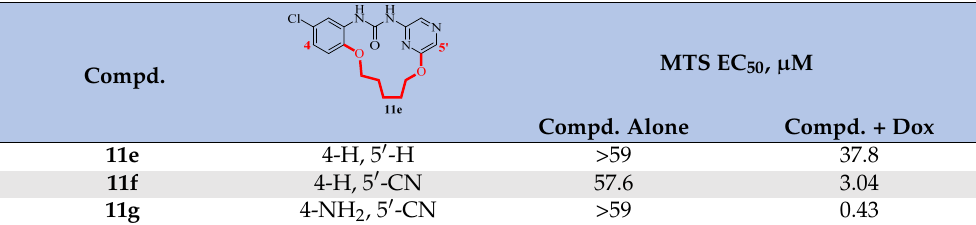
Table 2. Cellular activities of macrocyclic chk1 inhibitors [35,36].